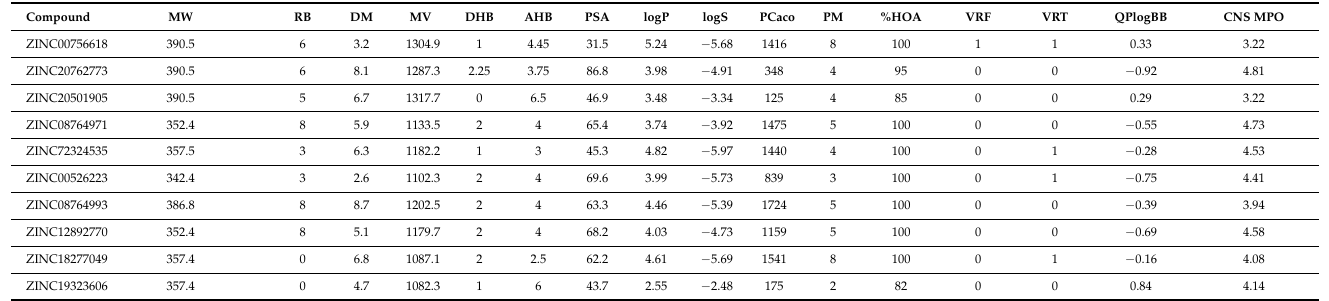
Table 3. Calculated absorption, distribution, metabolism, elimination, and toxicity (ADMET) parame- ters of the compounds.